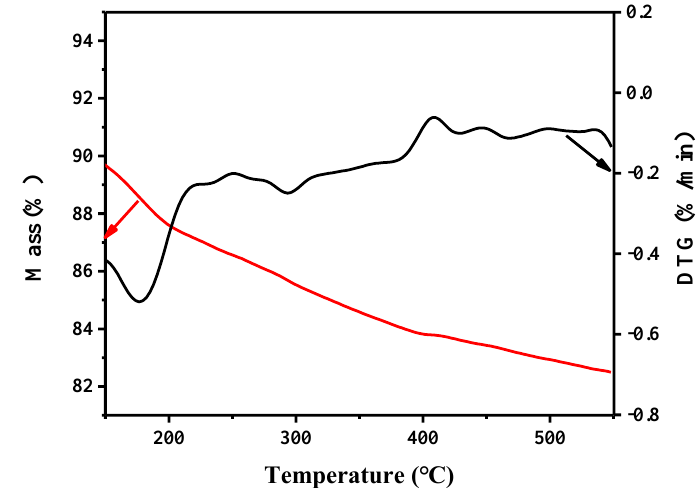
Figure 2. Thermogravimetric and differential thermogravimetric (TG – DTG) curves of the VPO/P-C catalyst.